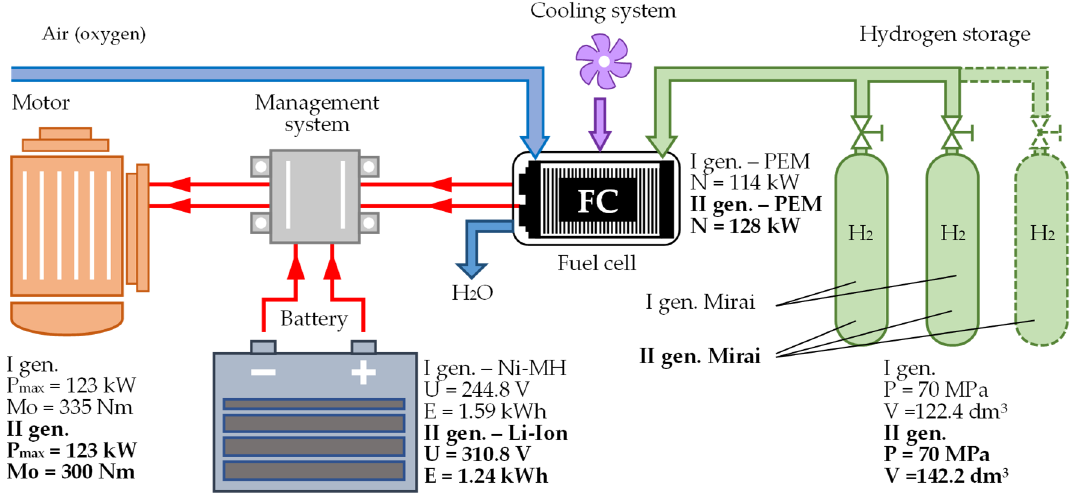
Figure 4. Diagram of the two drive generations analyzed in the article.